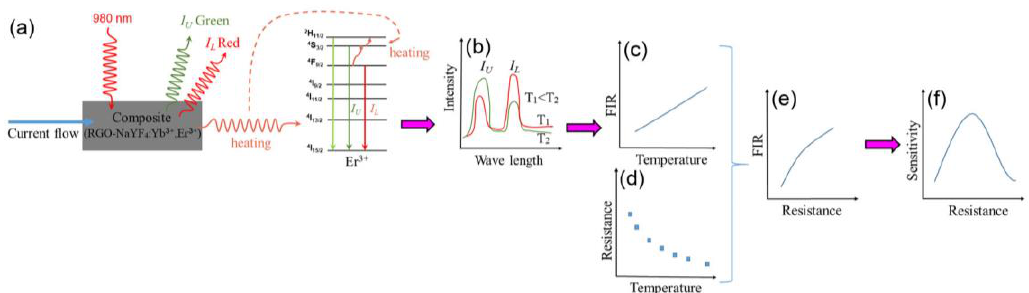
Figure 1. Schematic illustration of the mechanism of detecting variable resistance by fluorescence intensity ratios (FIR) technology. ( a ) Mechanism diagram of sensing under infrared excitation and current flow. ( b ) Fluorescence intensity. ( c ) The fitted curve of temperature dependent FIR based on Boltzmann distribution law. ( d ) Dependence of resistance on temperature. ( e ) The fitted curve of resistance dependent FIR. ( f ) Dependence of sensitivity on resistance.